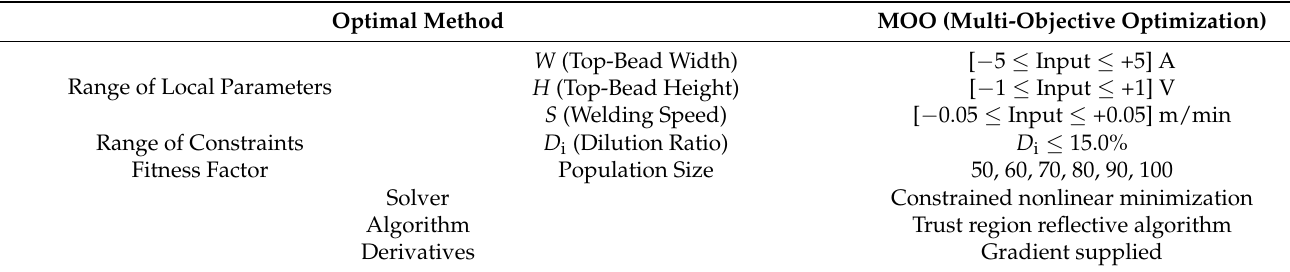
Figure 10. Flow chart for the multi-objective optimization (MOO) method to predict welding parameters. Table 12. MOO algorithm parameters and their values.